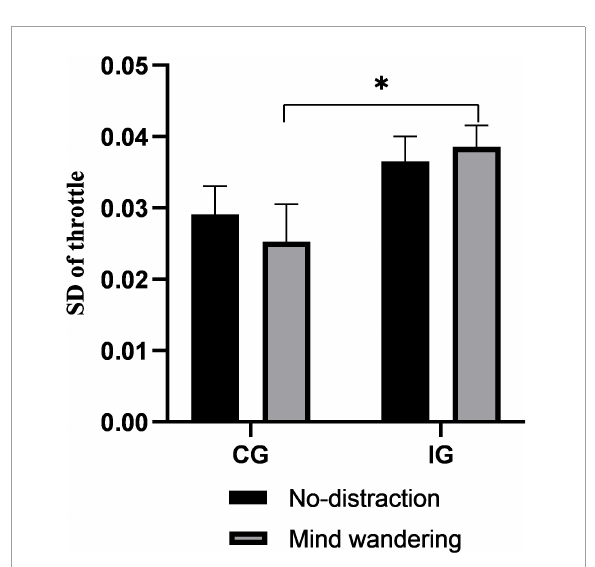
FIGURE3 The effect of mind wandering (MW) on the throttle. ∗∗∗ P < 0.001; ∗∗ P < 0.01; ∗ P < 0.05. MW, mind wandering; SD, standard deviation; IG, insomniac group; CG, control group.